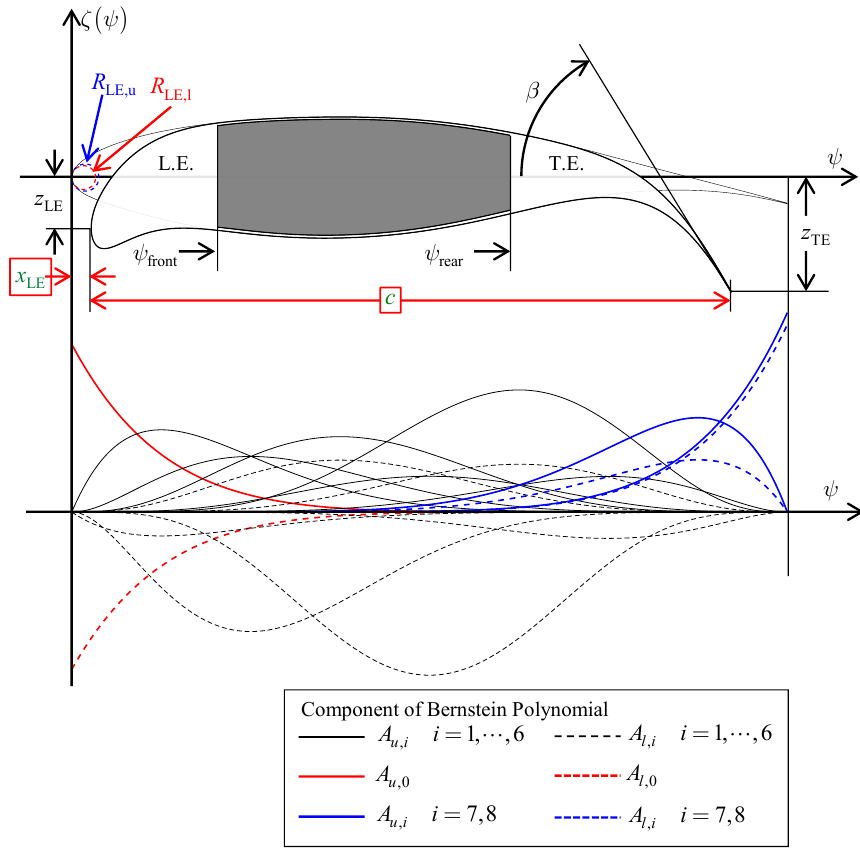
Figure 2. The geometric parameters describing the class/shape transformation (CST) airfoil and the corresponding Bernstein polynomial of the baseline shape. R LE is the dimensional radius of leading edge curvature, the subscripts ,u and ,l represent upper and lower surfaces. z LE and z TE are the vertical positions of leading and trailing edge points. x LE and x TE are chord-wise positions. β is the trailing edge’s boat-tail angle. A is the coefficient that scales each corresponding Bernstein